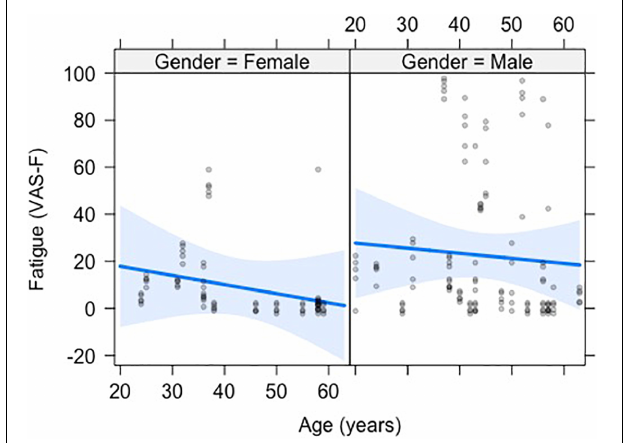
FIGURE 1 | The negative relationship between visual analog scale of fatigue (VAS-F) and age is shown. The data from men and women are shown separately to demonstrate the similarity of the effect of age in the two groups. The blue line represents the best fitting linear relationship between VAS-F and age. The 95% confidence interval around this line is plotted in lighter blue. The data are represented by gray circles.